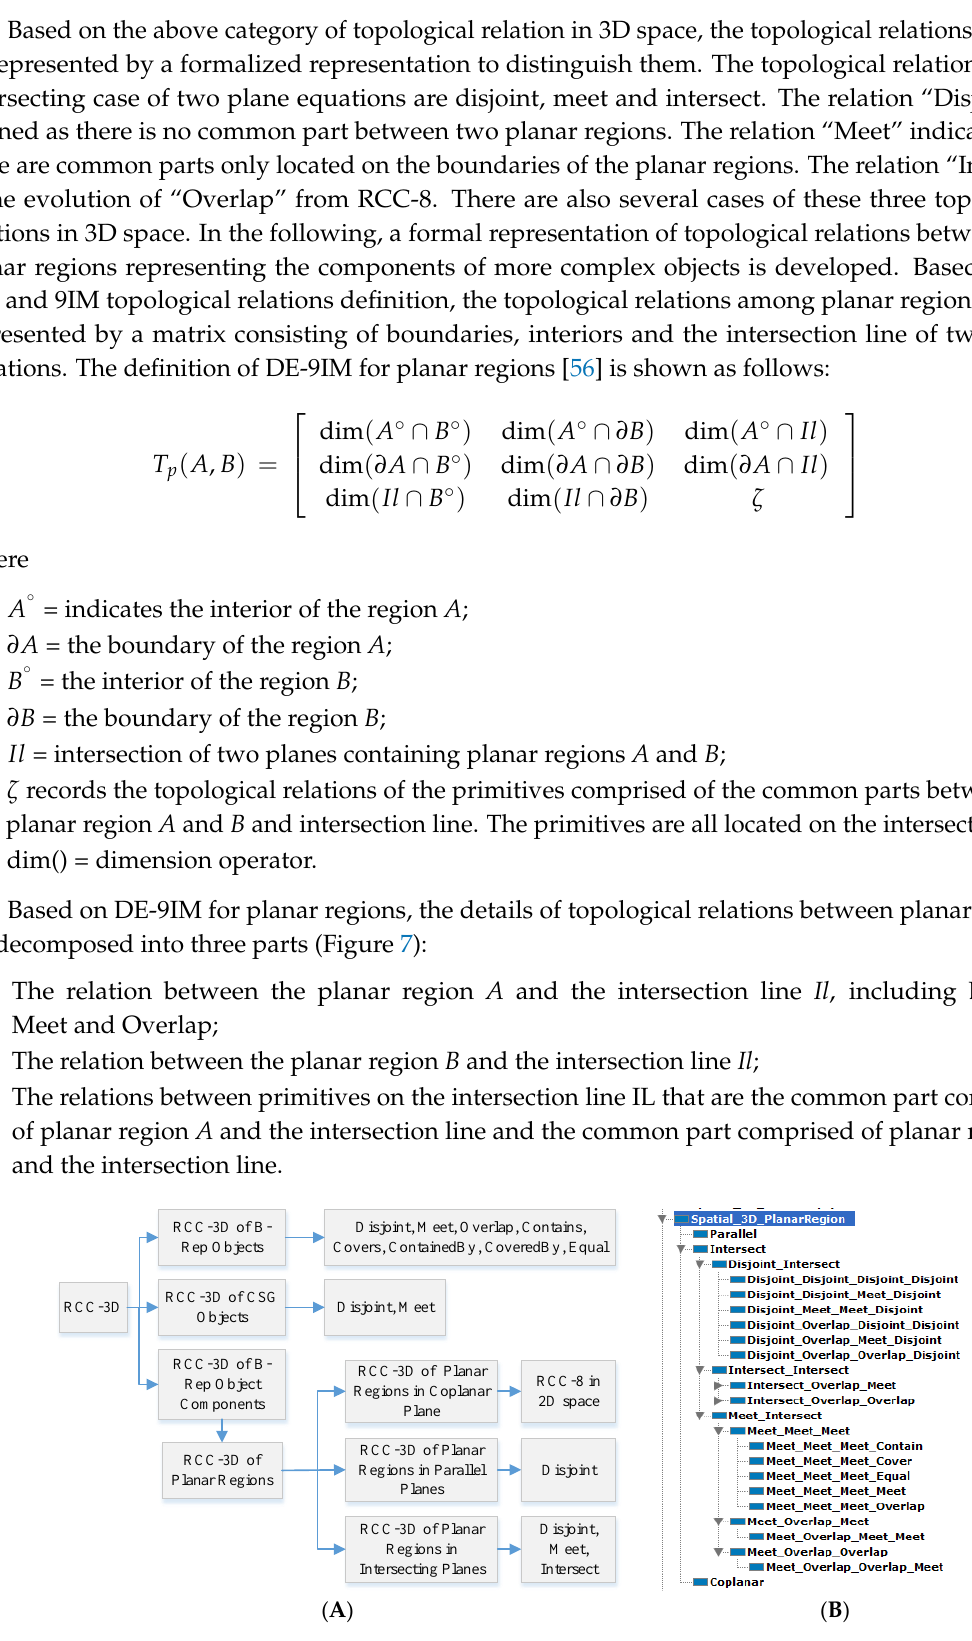
Figure 6. Classification of topological relations in 3D space ( A ), and their formalized representation in the ontology ( B ).